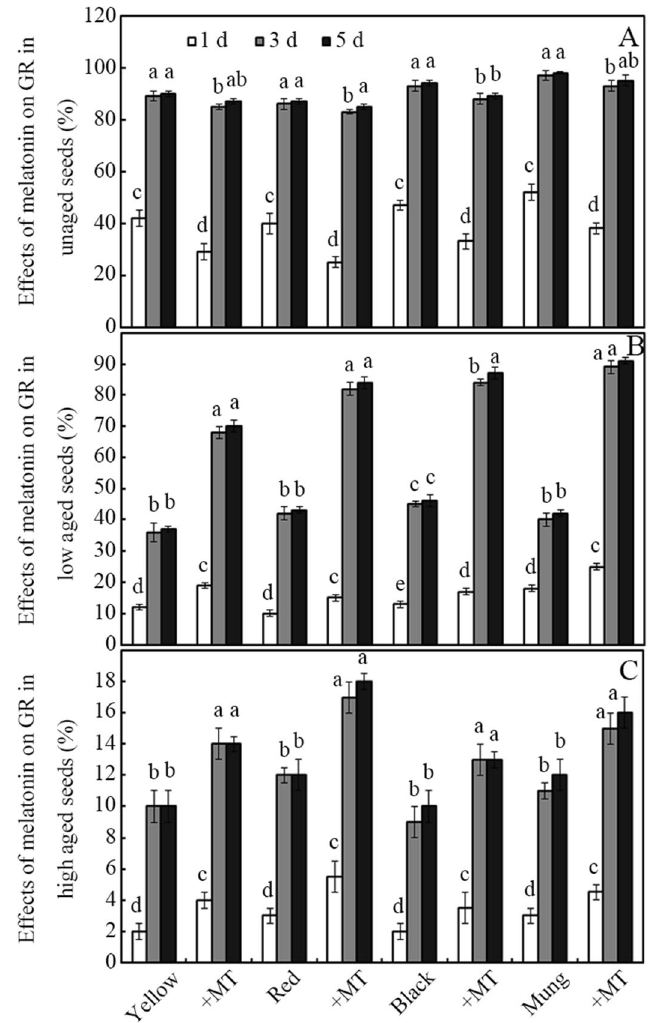
Figure 1. Effects of melatonin on aged seed germination. Recovery effects of melatonin on the germination rate (GR) in unaged ( A ), low aged ( B ) and high aged ( C ) bean seeds imbibed for 5 days. Bars represent standard deviations of the mean ( n = 3). Means within each bean type followed by the same letter are not significantly different ( p ˂ 0.05). MT, melatonin; Yellow, yellow soybean; Red, red bean; Black, black soybean; Mung, mung